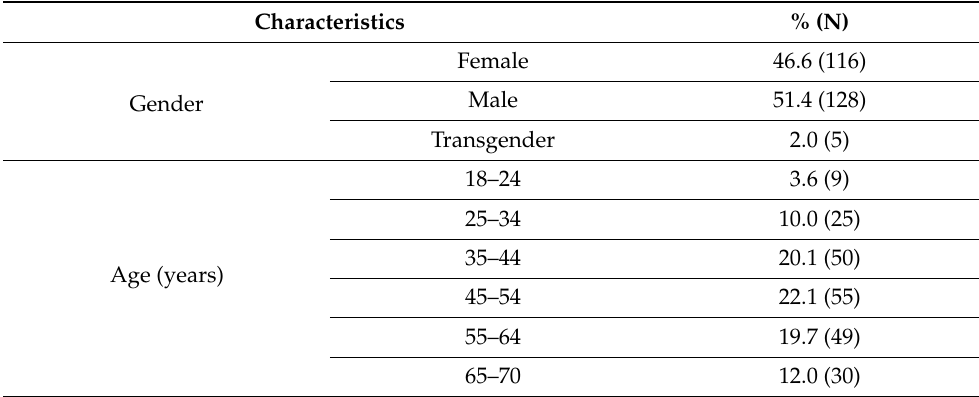
Table 1. Participant characteristics (n =